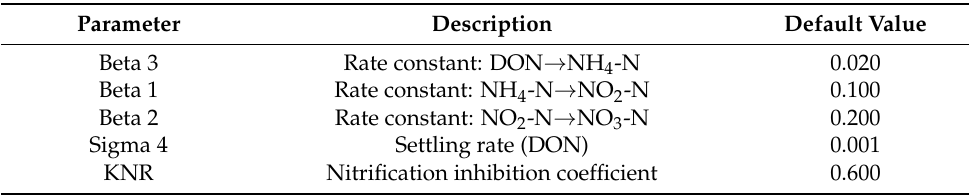
Table 4. Main parameters related to NO 3 -N dynamics provided in HEC-RAS.